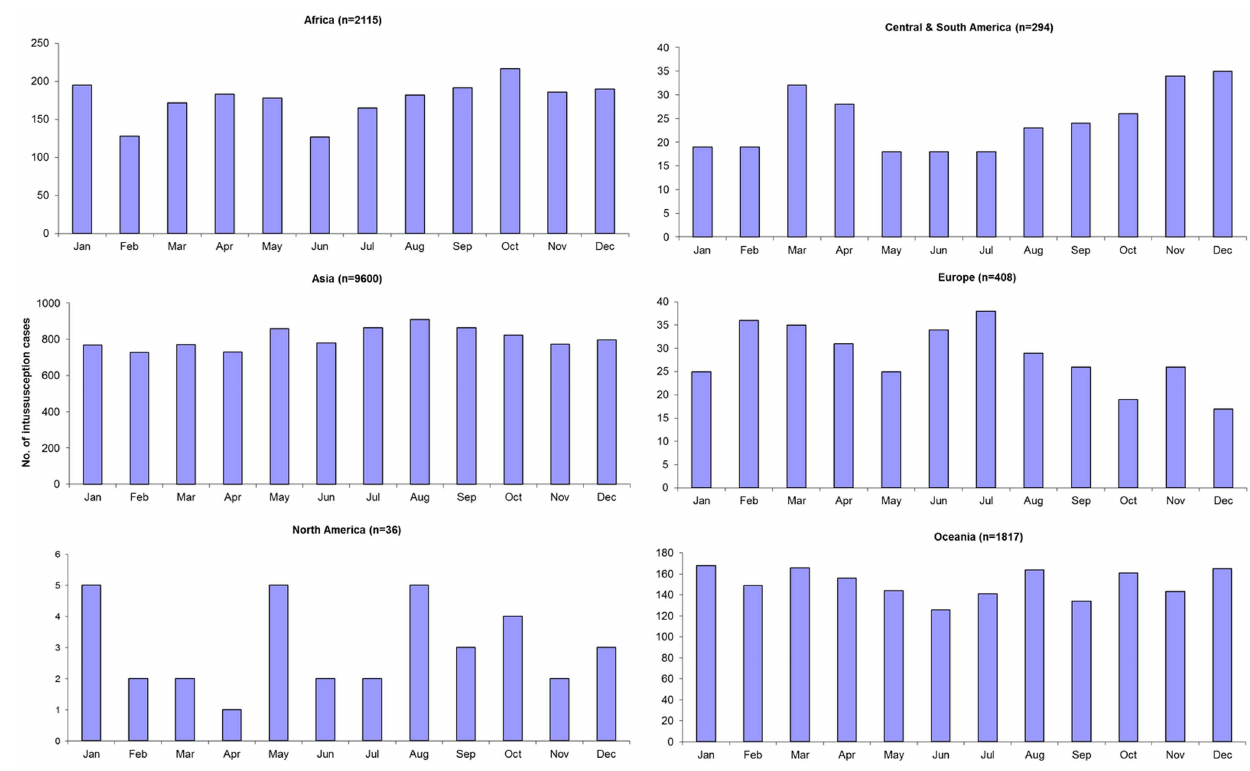
Figure 5. Seasonality of intussusception, by WHO region.